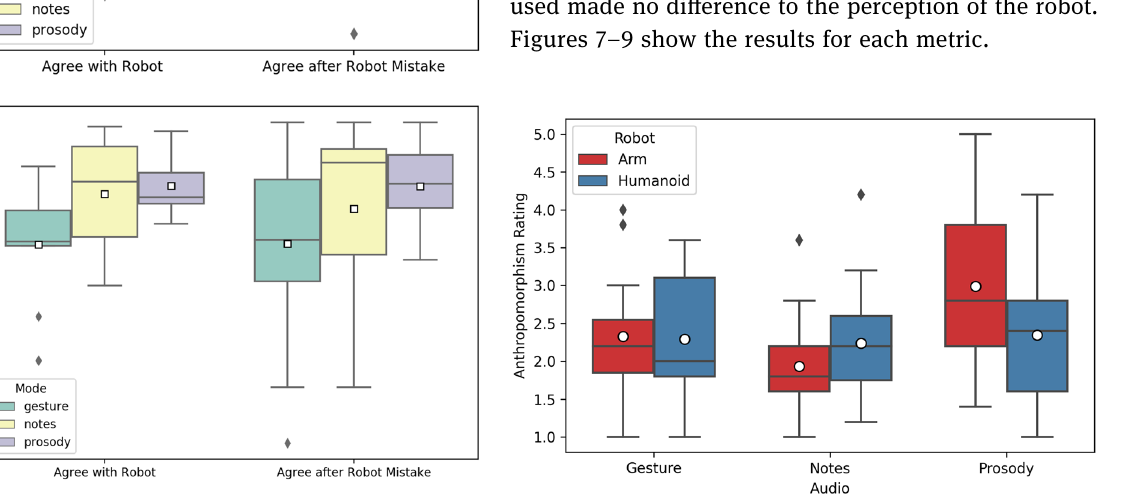
Figure 6: Box plots showing percentage of answers agreeing with the robot overall and after the robot made a mistake ( means indi - cated by white squares ) : ( a ) arm, ( b ) humanoid.